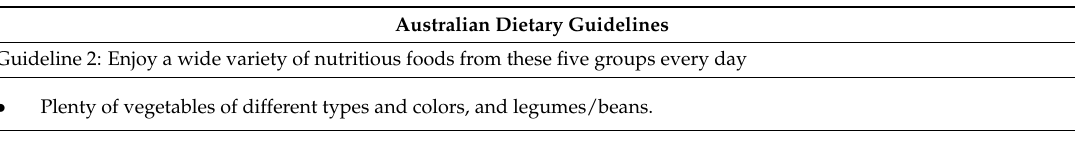
Table A2. Relevant Australian Dietary Guidelines [4] and Australian Guidelines to Reduce Health Risks from Drinking Alcohol [47] used to construct the